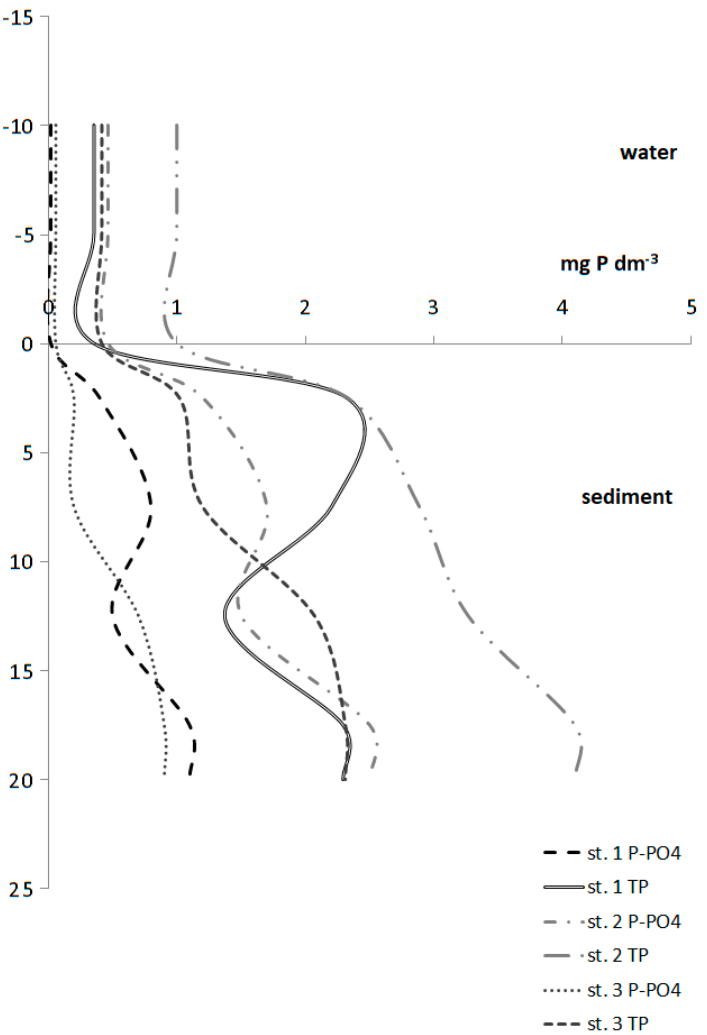
Figure 5. The total phosphorus (TP) and mineral P profiles in the water–sediment interface of Długie Lake.